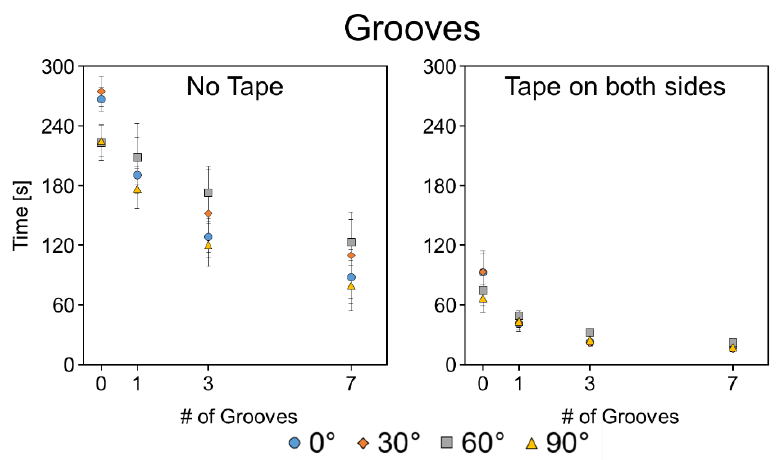
Figure 9. Angled wicking data for untaped and taped channels with lengthwise grooves. Data presented as mean ± SD. n = 5 .